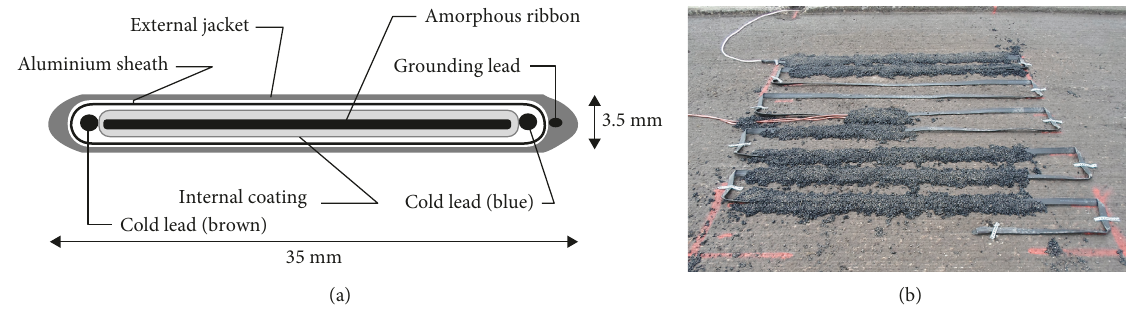
Figure 1: Ribbon section and laying of the heating element (protective cold asphalt on the